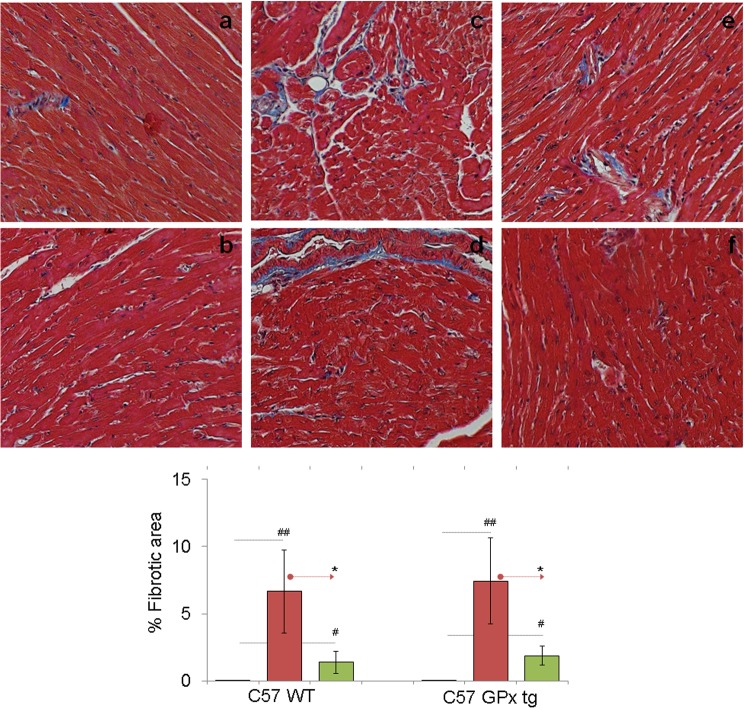
Cardiac fibrosis is controlled in GPx transgenic mice (± therapeutic vaccine).Mice (GPxtg and WT) were infected and vaccinated as in Fig 1. Paraffin-embedded left ventricular (LV) heart sections (5 μm) were examined by Masson’s trichrome staining. Shown are representative images (collagen fibers: blue, nuclei: black, background: red) of tissue sections from normal (a&b), infected (c&d), and infected/vaccinated (e&f) mice harvested during chronic disease phase (>150 days post-infection, magnification: 20X). (B) The fibrosis score was derived from two different experiments (n = 4 mice per group per experiment), and was calculated as described in Materials and Methods section.